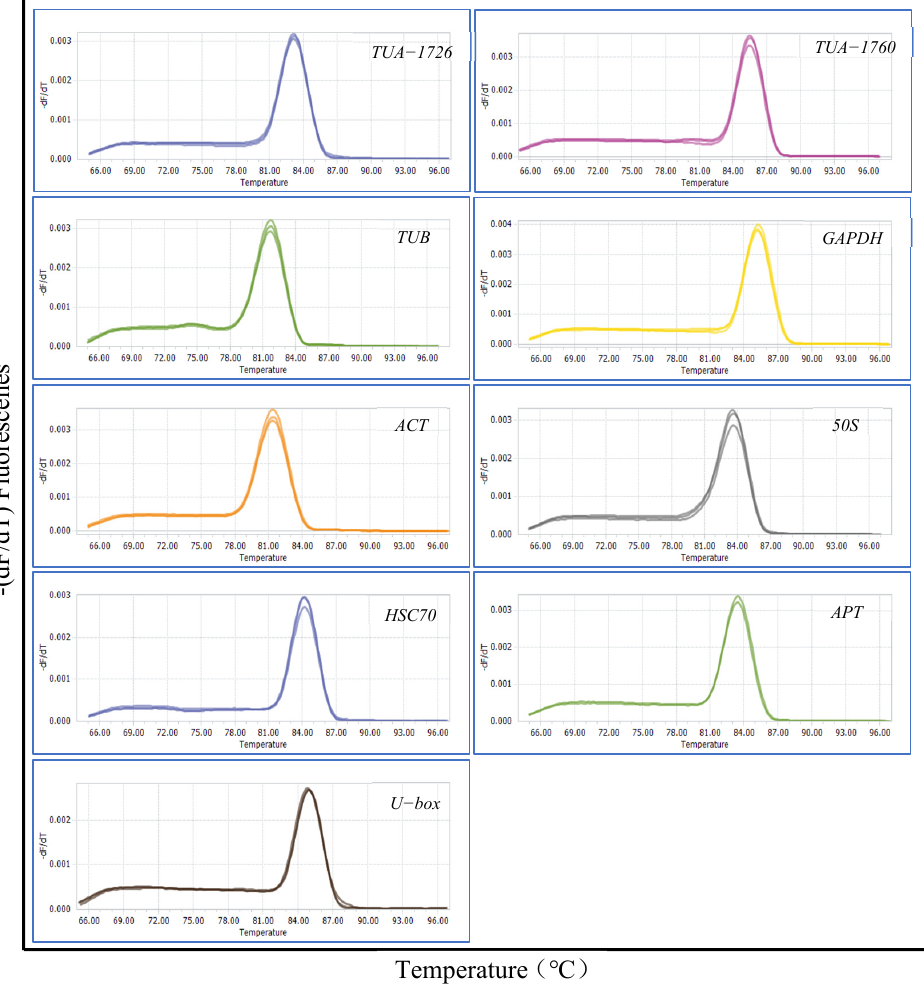
Figure 1. Melting curves of 9 candidate reference genes.